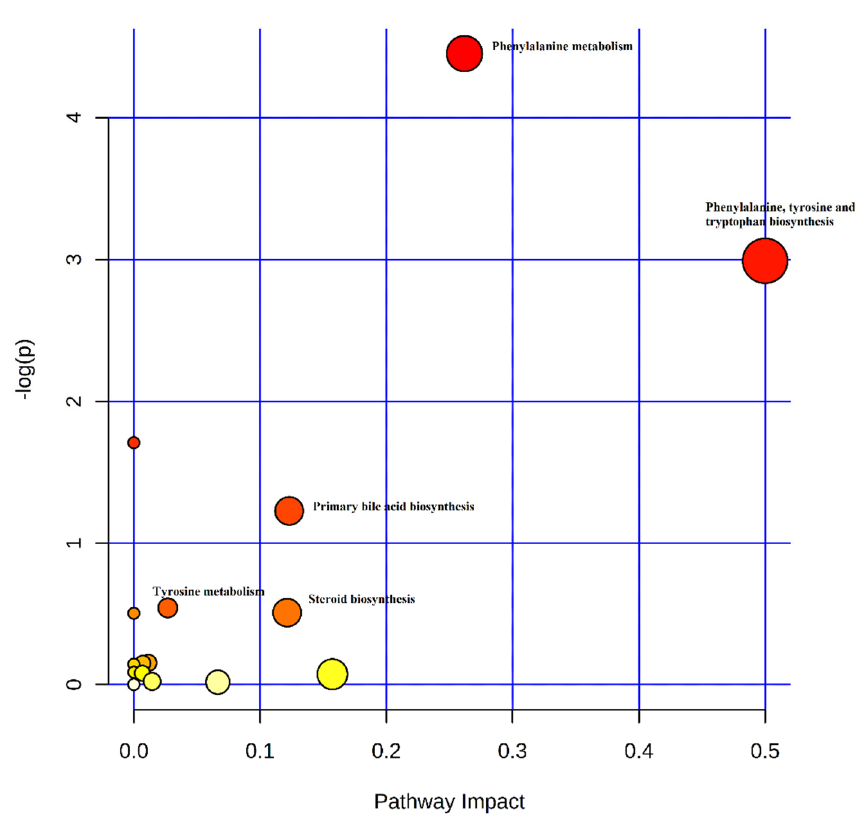
Figure 2. Enriched pathways of serum metabolites in neonatal piglets affected by iron deficiency. Each node marks a pathway, with larger sizes and darker colors representing higher pathway enrichment and higher pathway impact